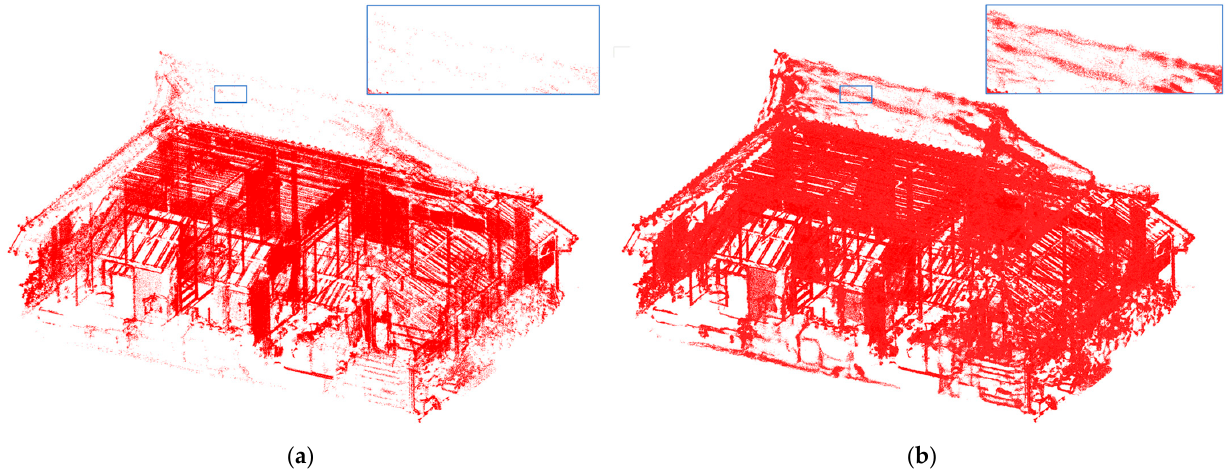
Figure 5. Extraction of edge points from 3D-scanned data in Figure 4. Standard binary extraction is adopted using change- of-curvature C λ as the feature value f and regarding the regions with f > f th as the 3D-edge regions. The threshold parameter f th is set to 0.25. ( a ) shows the initially extracted points, and ( b ) shows the result of applying our upsampling network.